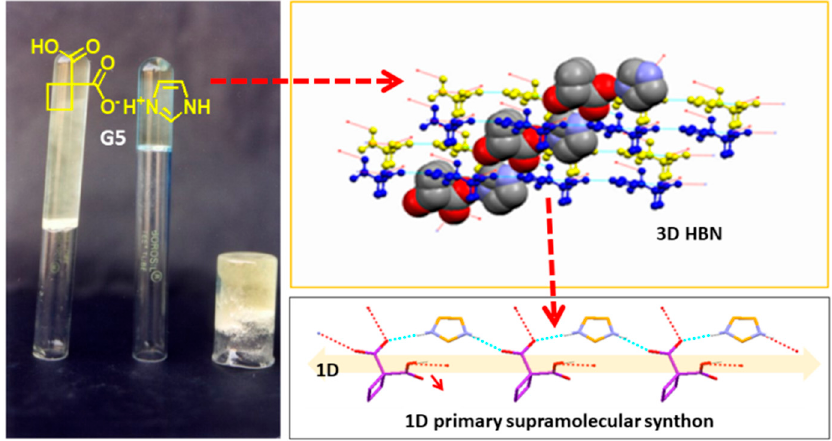
Figure 2. Nitrobenzene gel of G5 and illustration of its crystal structure displaying 1D primary supramolecular synthon.